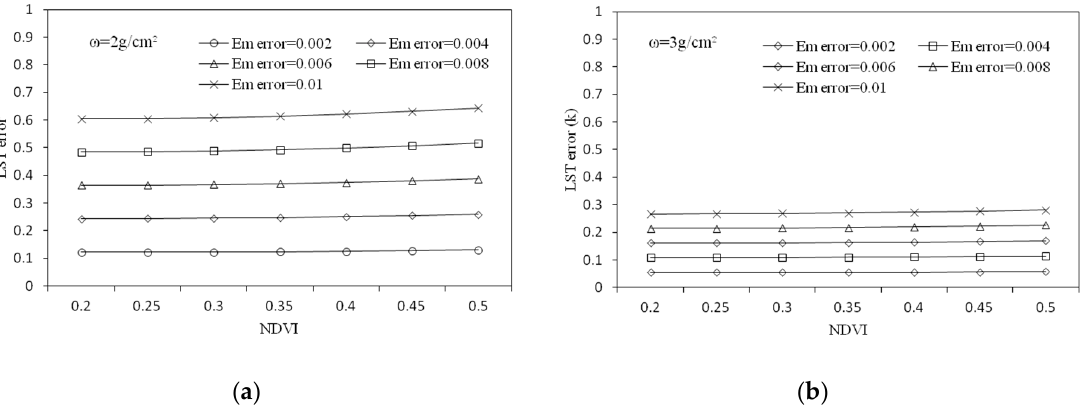
Figure 11. LST estimation error of the split window algorithm in the case of different LSEs as a result of the estimation error in LSE. ( a ) when the water vapor content is 2 g/cm², ( b ) when the water vapor content is 3 g/cm².